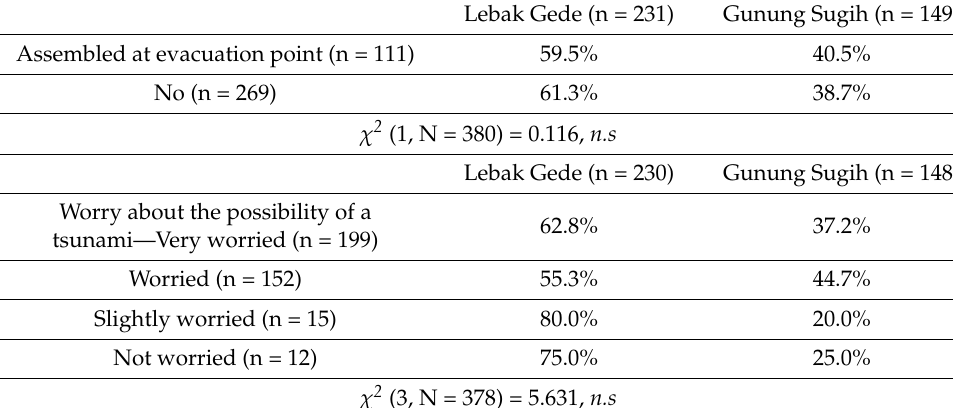
Table 10. Evacuation behavior by village